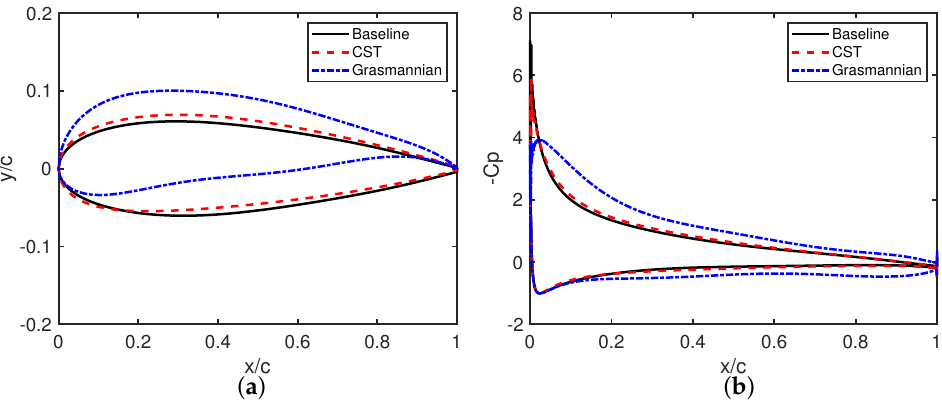
Figure 6. Comparison of the geometry and pressure coefficient of the subsonic case: ( a ) airfoil shape; ( b ) pressure